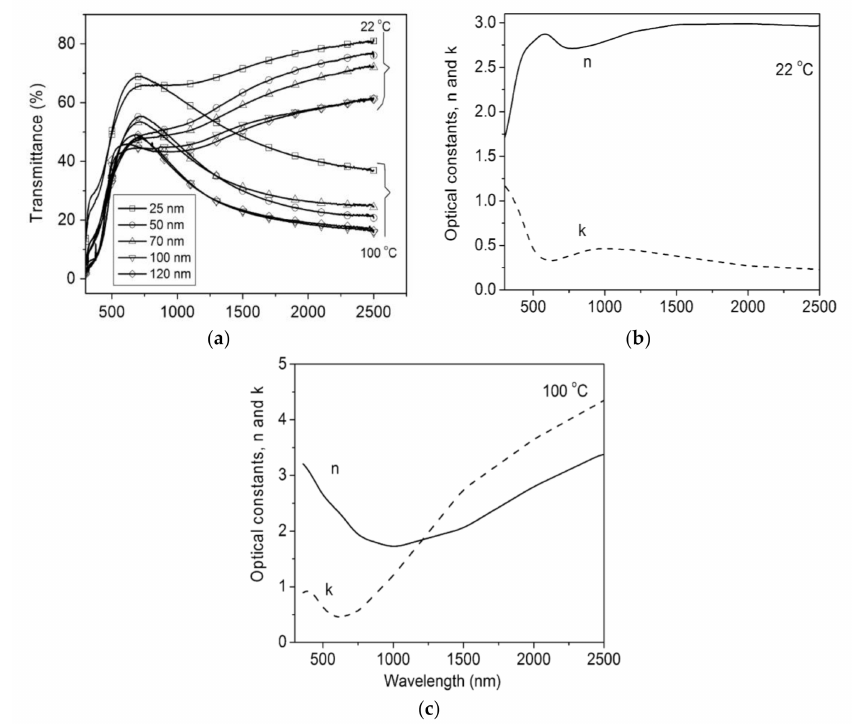
Figure 3. ( a ) Spectral transmittance for VO 2 , measured above and below its precise critical temperature (T C ); ( b ) spectral optical constants, n and k, for VO 2 films, measured above and below its Tc; ( c ) Spectral opticalconstants, n and k, for VO 2 films, above the Tc. Reproduced from [51], Elsevier: